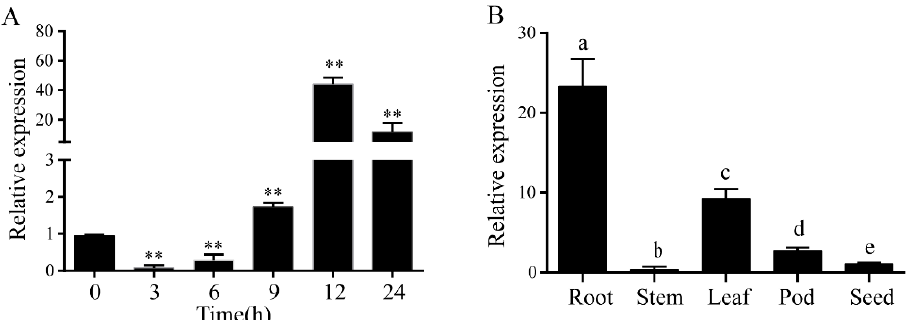
Figure 1. Expression pattern of GmLecRlk . ( A ) Expression analysis of GmLecRlk in response to salt stress by qRT-PCR. Asterisks indicate a significant difference compared with the corresponding control (Student’s t test: ** p < 0.01). ( B ) Tissue specificity analysis of the GmLecRlk gene. A one-way ANOVA was used to generate the p values. Error bars represent standard deviations. Values represent the means of three biological replicates.